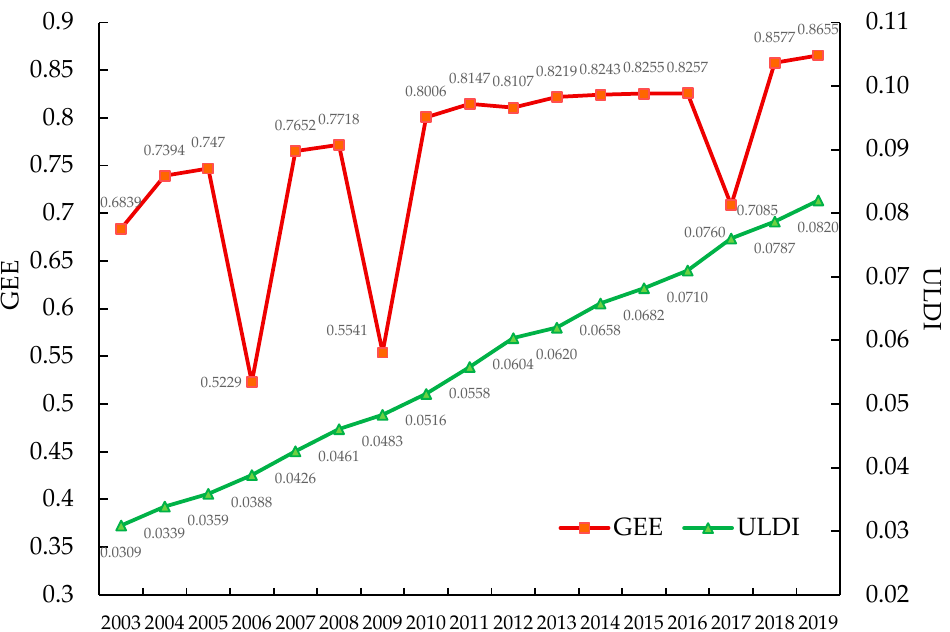
Figure 1. Calculation results and time-series trend characteristics of GEE and ULDI.